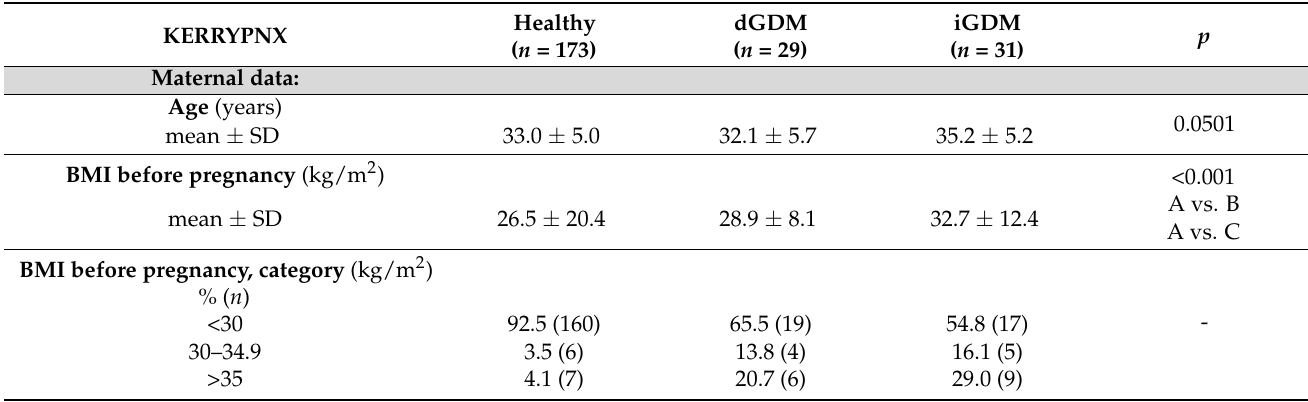
Figure 1. Flow diagram. Distribution of maternal–neonatal pairs by inclusion or exclusion with the reasons for exclusion. Furthermore, subdivision of the included pairs according to healthy, dietary- and insulin-dependent GDM. Table 1. Maternal, neonatal, and sample processing data of group A (healthy mothers), group B (dGDM), and group C (iGDM).